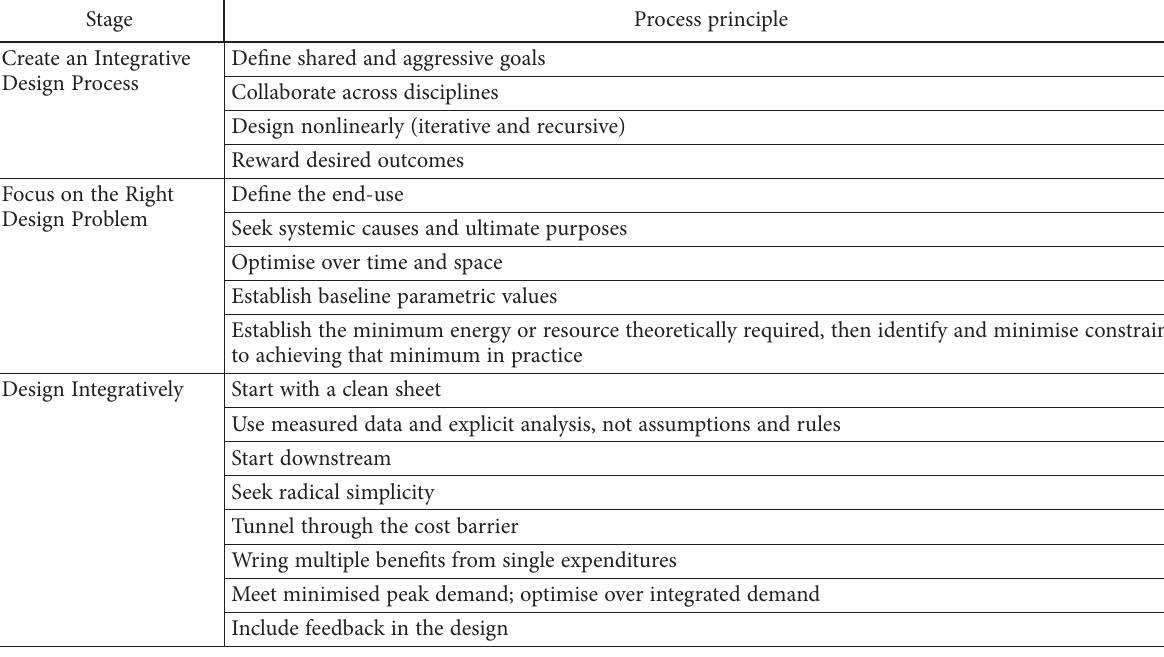
Table 2. Integrative design stages and process principles (adapted from Lovins et al., 2010)